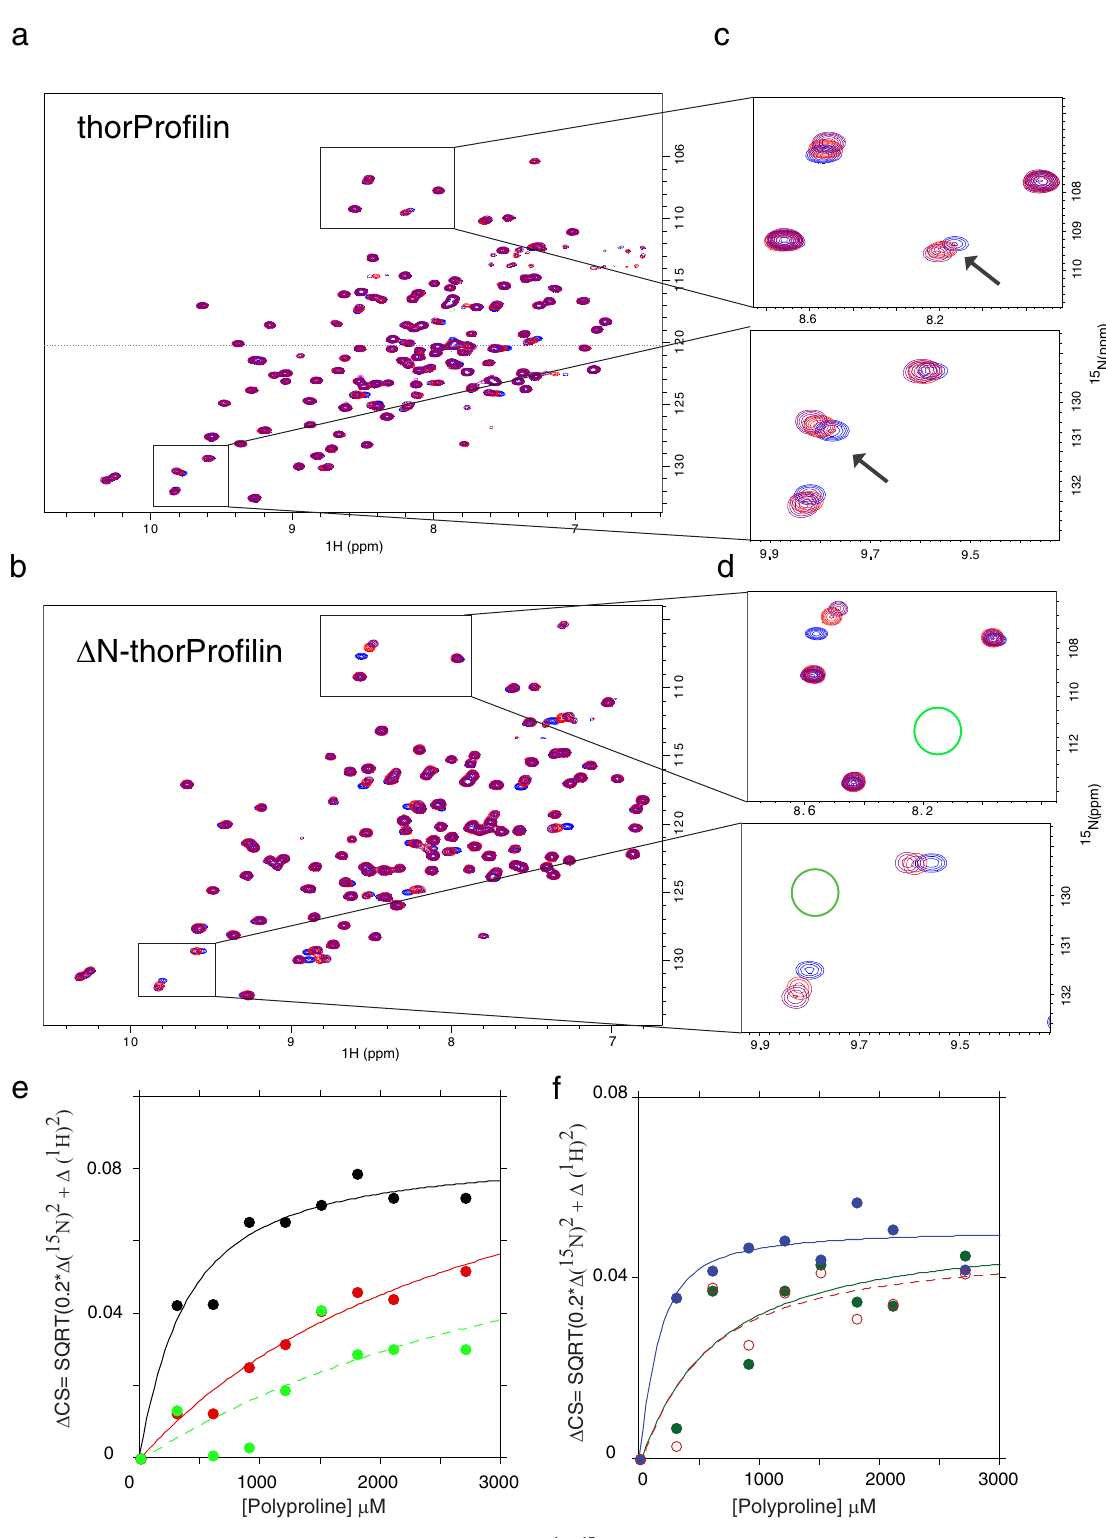
Fig. 6 Thorarchaeota pro fi lin interacts with polyproline. NMR monitored 1 H – 15 N chemical shifts for the binding reaction of a fi xed concentration of thorPro fi lin (200 μ M) ( a ) and/or Δ N-thorPro fi lin ( b ) (200 μ M) with different concentrations of polyproline from VASP (PPPAPPLPAAQ) respectively. The following VASP concentrations were used; 0 μ M (blue), 5 mM (red), 7.0 mM (purple). c , d Expansions from ( a ) and ( b ) showing the shift of some interacting residues as the concentration of polyproline increases. The arrows in ( c ) indicate residues from the N-terminal extension interacting with polyproline. These residues are absent in the Δ N-thorPro fi lin as indicated with the green circle in ( d ). e , f Chemical shift plotted as a function of polyproline (VASP) concentration for a few residues for ( e ) thorPro fi lin and ( f ) Δ N-thorPro fi lin. The chemical shift was fi tted to the equation describing the equilibrium interaction of two biomolecules as described above. The K D estimated from this fi ts range between 200 – 500 μ